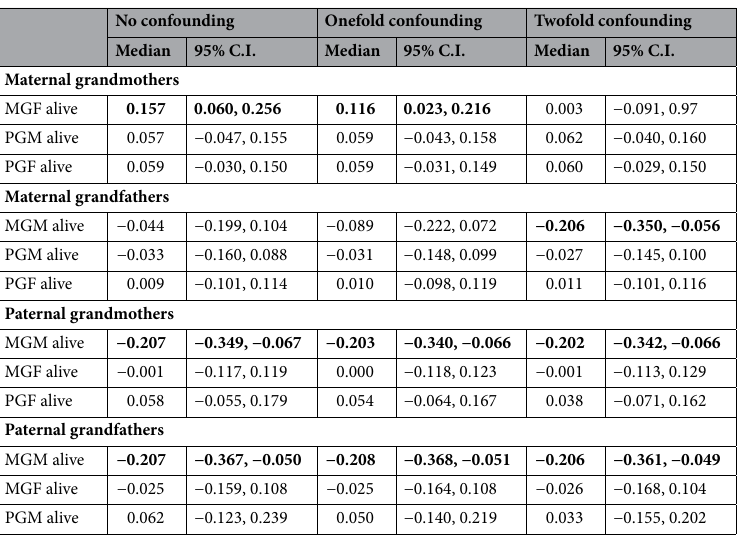
Table 3. Sensitivity analysis of the regression coefficients and their 95% credibility intervals (C.I.) for other grandparent types’ influence on a focal grandparent’s investment from the base model when there was either 1- or twofold within-lineage confounding. Bolded cases indicate statistically non-zero